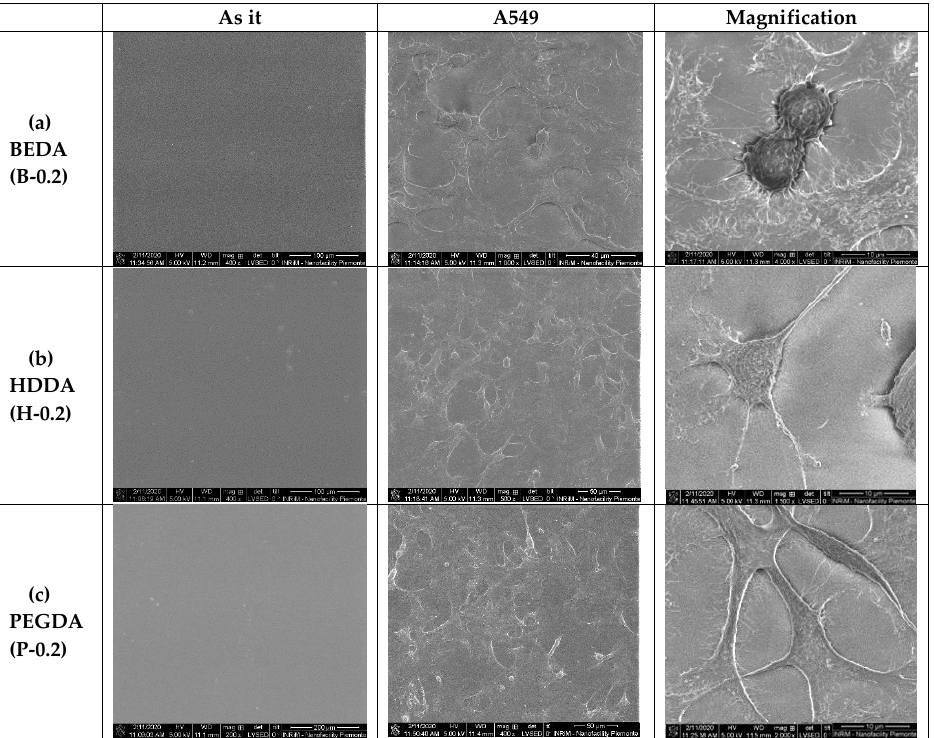
Figure 4. Environmental Scanning Electron Microscope (ESEM) images of the A549 cells cultured on the three di ff erent acrylate samples ( a ) BEDA, B-0.2, ( b ) HDDA, H-0.2, ( c ) PEGDA, P-0.2. For each formulation, three di ff erent SEM images are shown, in particular, the polymer as it is without cells and the same polymer with A549 at di ff erent degree of magnification (scale bar 100, 50, and 10 microns, respectively).